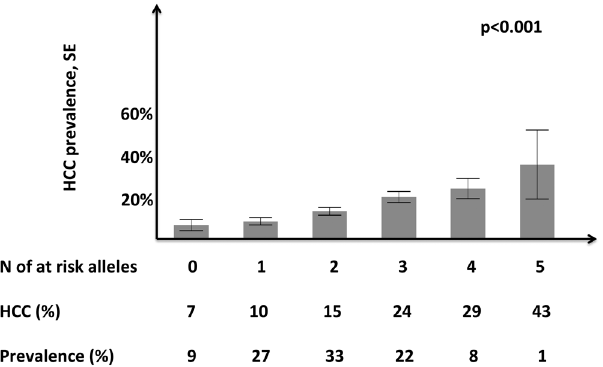
Figure 2. Risk of hepatocellular carcinoma according to the number of PNPLA3 I148M, TM6SF2 E167K, and MBOAT7 rs641738 C > T risk variants in 765 Italian patients with NAFLD. HCC: hepatocellular carcinoma; SE: standard error. Comparisons were performed by a multivariate logistic regression setting HCC as dependent variable, and the association with genetic risk factors (numbers of at risk alleles carried) was analyzed assuming an additive model. p < 0.001 for the association of the number of risk alleles with HCC, both at unadjusted analysis and after adjustment for age, sex, obesity, T2DM, and presence of advanced fibrosis stage F2-F4.